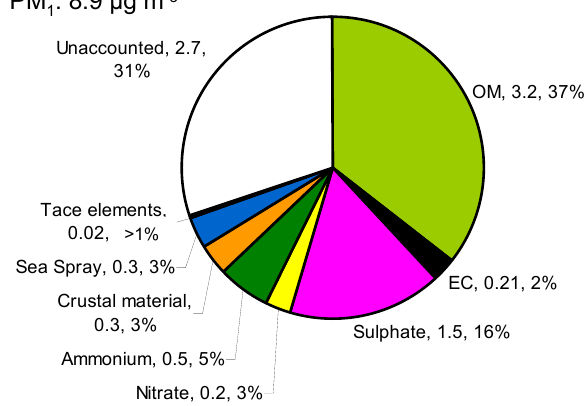
Fig. 1. Chemical composition of PM 1 at MSY from 24/09/2009 to